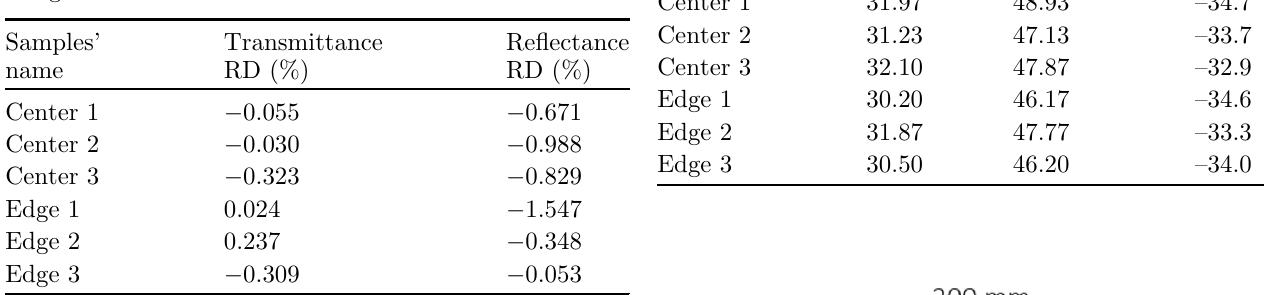
Table 2. Integrated transmittance and re fl ectance rela- tive difference (RD) between cooling with or without Cooling Press. The transmittance ’ s order of magnitude is 84%. While the re fl ectance is of the order of 10.5%. Integration have been made between 300 nm and 1200 nm.